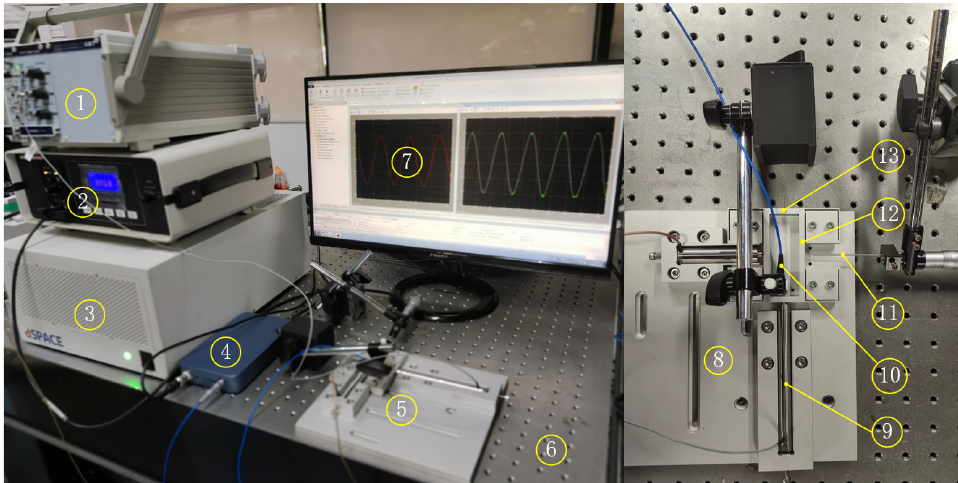
Figure 9. Experimental setup: (1) voltage amplifier; (2) fiber-optic displacement sensor; (3) dSPACE control system; (4) capacitive displacement sensor; (5) designed compliant 2-DOF ejector pin mechanism; (6) vibration isolation stage; (7) host display; (8) fixture; (9) piezoelectric actuator; (10) capacitance displacement sensor probe; (11) fiber-optic displacement sensor probe; (12) compli- ant mechanism; and (13) eject pin.